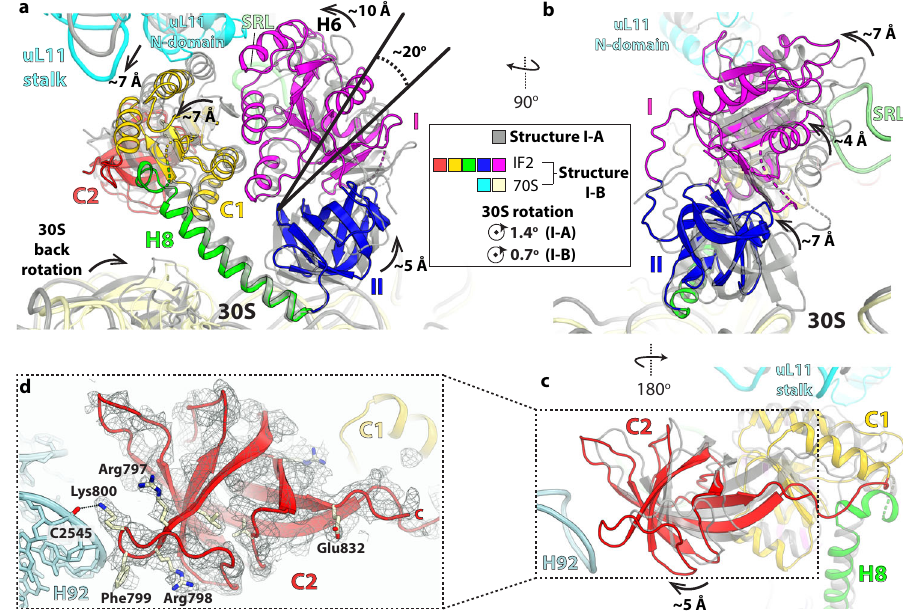
Fig. 6 Compact IF2 is loosely bound to the ribosome in structure I-B. a Alignment of the 23 S rRNA in structures I-A and I-B shows that domain I (G- domain) rotates inward by ~20° around the SRL in structure I-B (colored domains) relative to structure I-A (gray). The center of rotation was taken around residue Gly 589 in domain II. The maximum displacement at the outskirt of domain I is ~10 Å, ~7 Å for domain C1, and ~5 Å for domain II. Concomitantly, the uL11-stalk moves inward by ~7 Å together with domain C1. In structure I-B, helix H6 in the G-domain of compact IF2 is proximal to the N-domain of ribosomal protein uL11. The displacement of domain II away from the 30 S subunit in structure I-B, combined with the reverse rotation of the 30 S subunit between structure I-A (~1.4°) and I-B (~0.7°), weakens the binding of IF2-GDP to the ribosome in structure I-B. b Orthogonal view of panel a showing that in structure I-B the G-domain moves farther from the SRL by ~4 Å, which may facilitate IF2-GDP dissociation from the ribosome. c In structure I-B, the rotation of IF2-GDP around the SRL brings domain C2 (red) near 23 S rRNA helix H92. d EM density map of domain C2 in structure I-B shows that residues Phe 799 and Lys 800 form a complementary surface with H92. We note that in extended IF2 residue Phe 799 interacts with the fMet residue attached to fMet- tRNA i fMet in structures II-A and II-B (see Supplementary Fig.